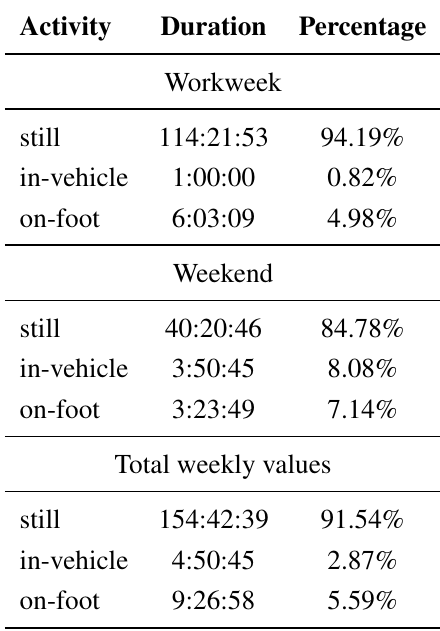
Table 5. Mobility of a single user during one week (Experiment